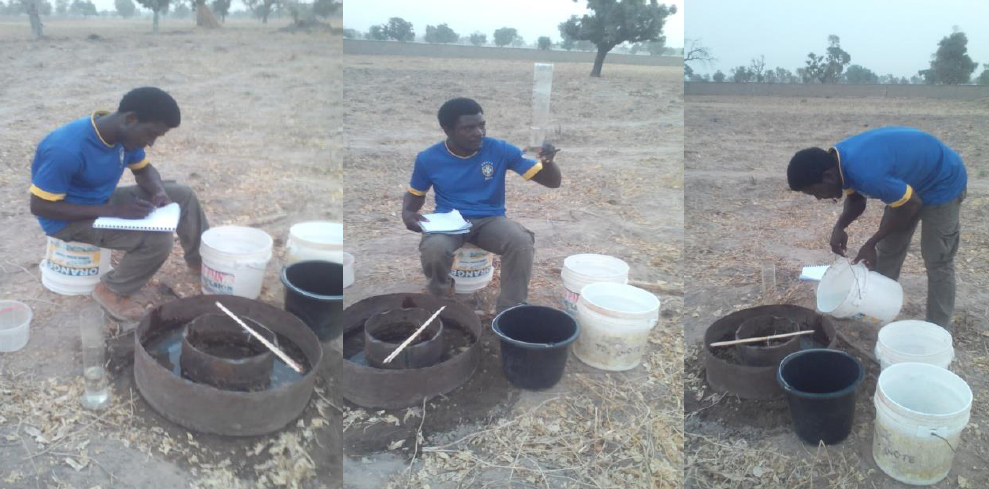
Fig. 4. Determining infiltration rate in the research